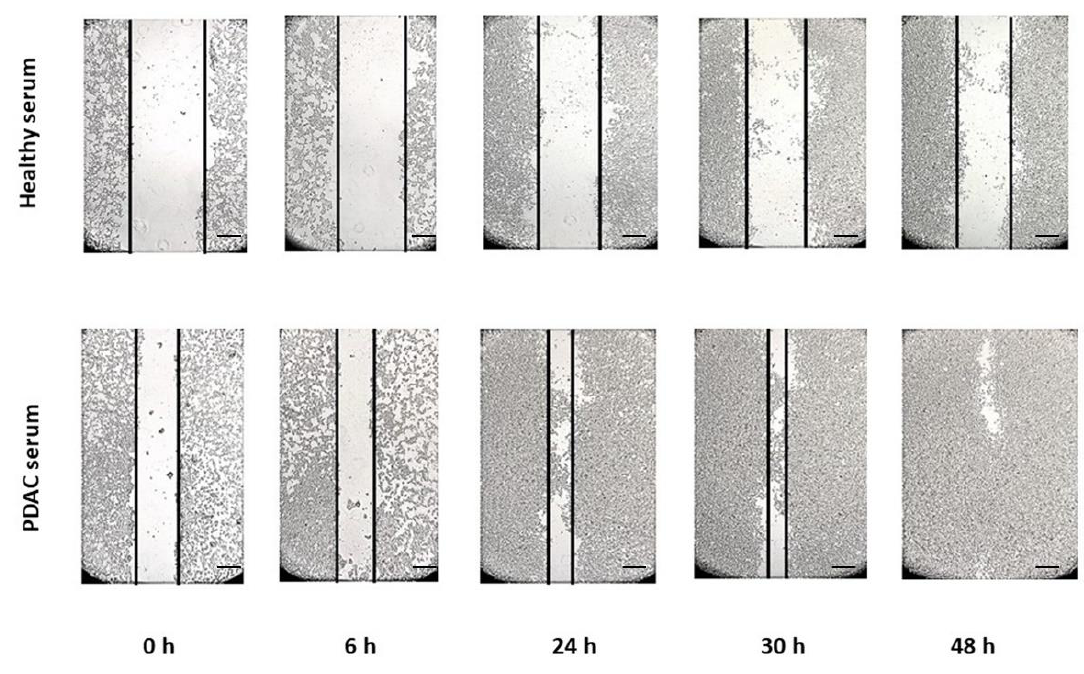
Figure 2. The representative wound healing migration assay for HEK293T cell line treated with healthy or PDAC sera. Scale bar = 400 μm.